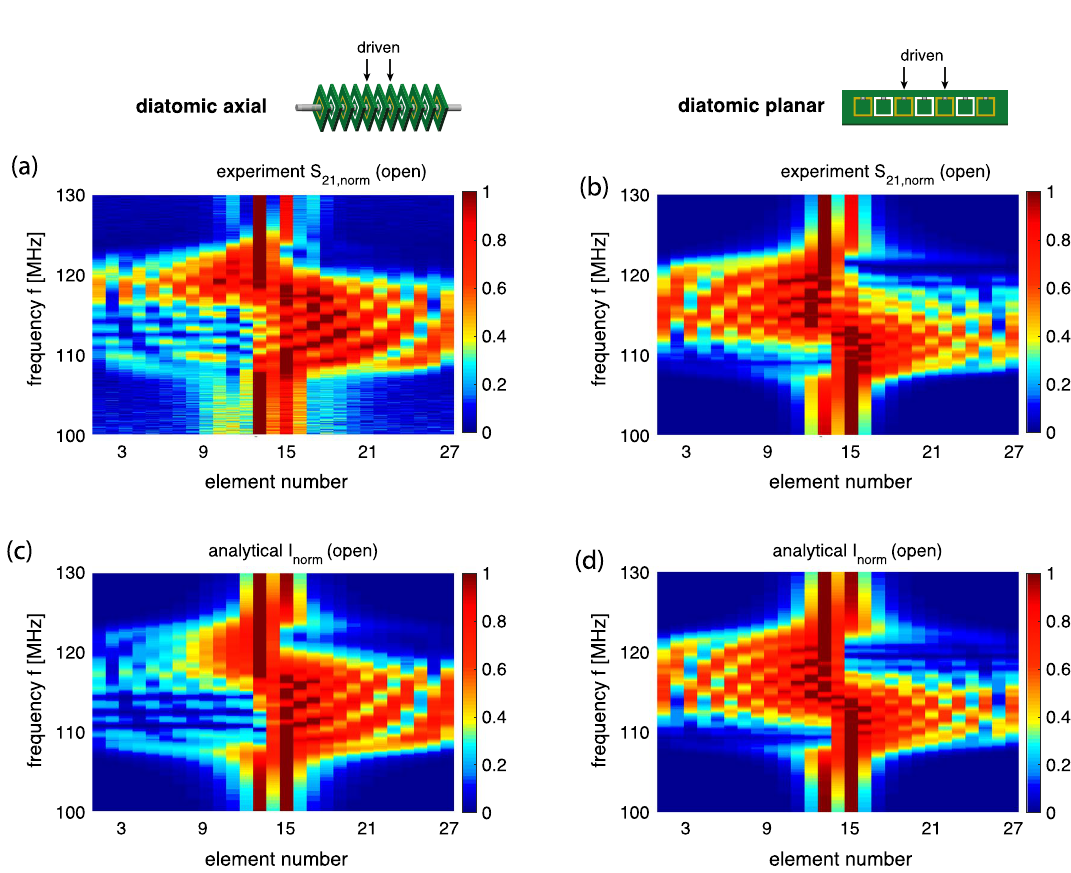
Figure 11. Switchable unidirectional power flow. The normalised current distribution in the 27 elements of the MI waveguides over frequency for an axial array (left column) and for a planar array (right column). ( a ),( b ): spectra for the magnitude of S 21 (experiment). ( c ),( d ): spectra for the current magnitude (analytical model). Array is open (not loaded). Diatomic excitation of elements 13 and 15 [ V 13 schematically by arrows in the